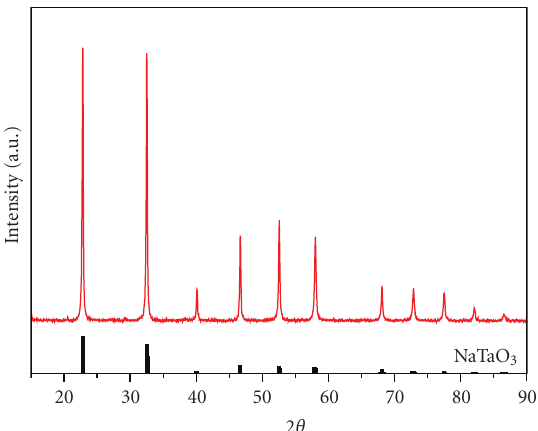
Figure 3: XRD pattern of NaTaO 3 powder synthesized by spray pyrolysis (mean residence time = 1.80 seconds, spray pyrolysis temperature = 1173K, precursor preparation temperature = 333 K, precursor concentration = 0.125 M, carrier gas (air) flow rate = 5L/min, Na/Ta = 1.00).